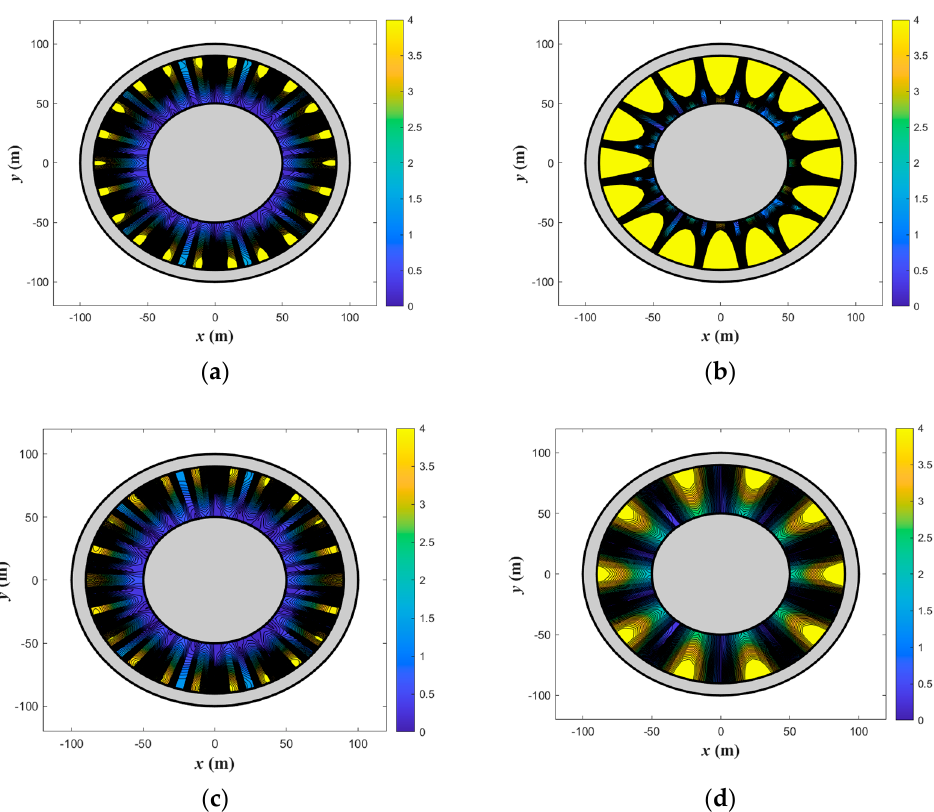
Figure 10. Normalised inner wave fields for individually oscillating floating circular platforms and ring structures at significant resonance frequencies: ( a ) (cid:1856) (cid:2869) /(cid:1860) (cid:3404) 0.1, (cid:1856) (cid:2870) /(cid:1860) (cid:3404) 0.1 (cid:4666)(cid:1863)(cid:1860) (cid:3404) 7.5(cid:4667) ; ( b ) (cid:1856) (cid:2869) /(cid:1860) (cid:3404) 0.1, (cid:1856) (cid:2870) /(cid:1860) (cid:3404) 0.2 (cid:4666)(cid:1863)(cid:1860) (cid:3404) 5.5(cid:4667) ; ( c ) (cid:1856) (cid:2869) /(cid:1860) (cid:3404) 0.2,(cid:1856) (cid:2870) /(cid:1860) (cid:3404) 0.1 (cid:4666)(cid:1863)(cid:1860) (cid:3404) 7.5(cid:4667) ; ( d ) (cid:1856) (cid:2869) /(cid:1860) (cid:3404) 0.2,(cid:1856) (cid:2870) /(cid:1860) (cid:3404) 0.2 (cid:4666)(cid:1863)(cid:1860) (cid:3404) 3.75(cid:4667) .